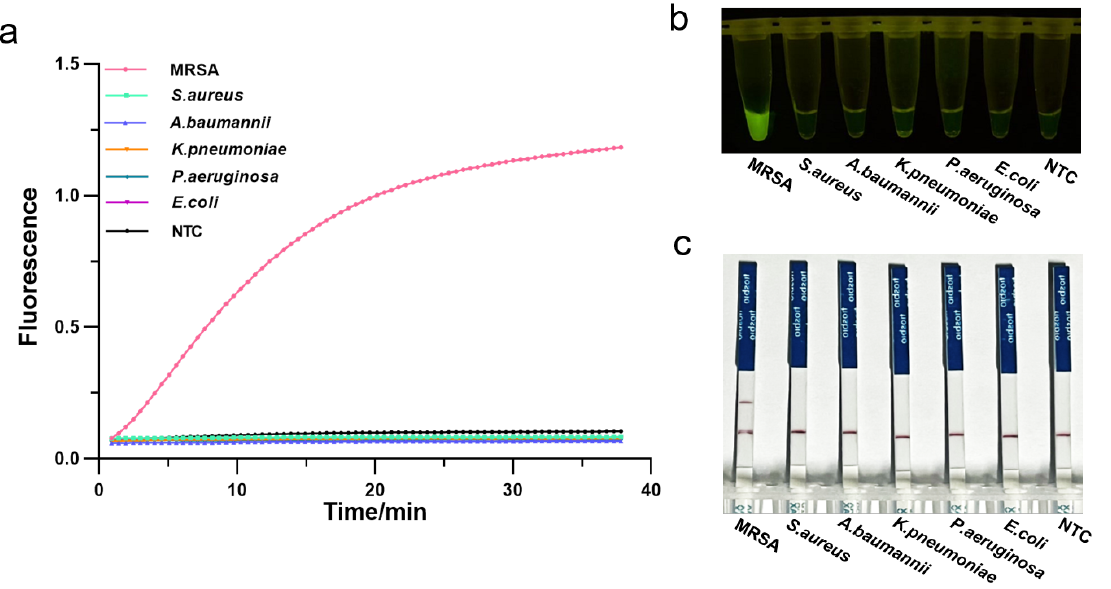
Figure 5. Determination of the specificity of one-tube RPA-CRISPR/Cas12a detection of MRSA using 5 common pathogenic bacteria. ( a ) Real-time fluorescence intensity curves of the RPA- CRISPR/Cas12a assays for MRSA and different bacteria strains. NTC: no template control. ( b ) End- point visualization fluorescence-based one-tube RPA-CRISPR/Cas12a detection of MRSA and 5 dif- ferent bacteria strains. A strong fluorescent signal was observed with the naked eye only when MRSA sample were added. ( c ) Specificity test of the RPA-CRISPR/Cas12a LFS detection assay. Only the MRSA sample showed a clear test